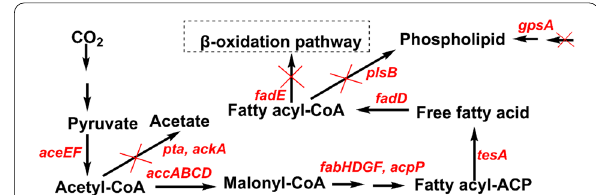
Fig. 4 Schematic diagram of the construction of a microbial metabolic pathway for the production of fatty acids. Two arrows represent multiple steps